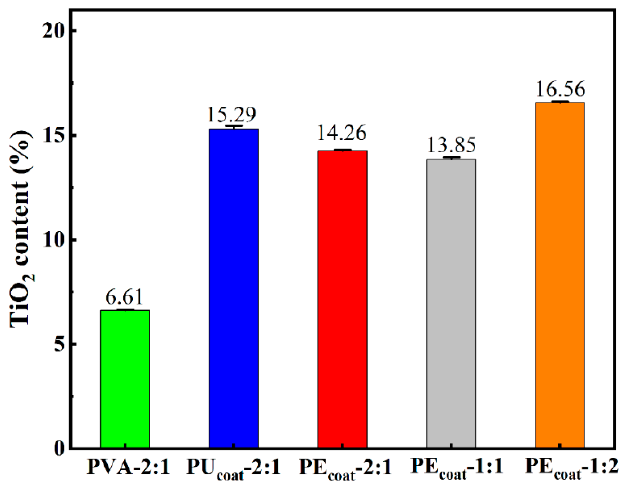
Figure 2. TiO 2 content in modified pigments.